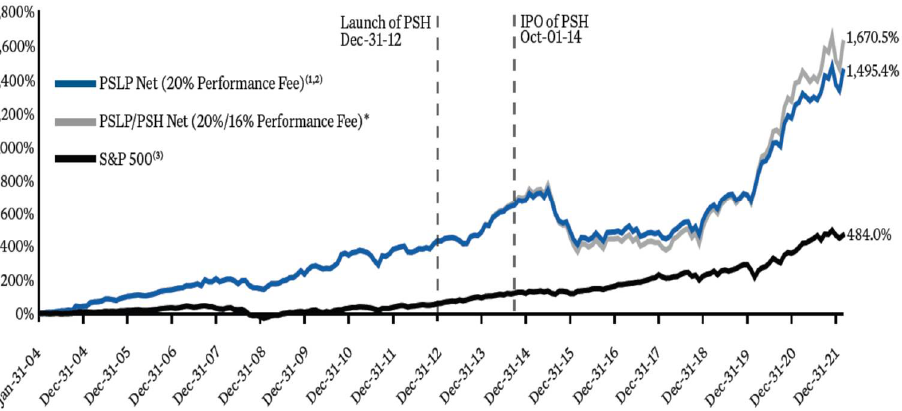
Figure 2. Pershing Square vs. the S&P500 NAV average performance (2004–2021). Source: Pershing Square Holdings Annual Report (2021, p. 2).